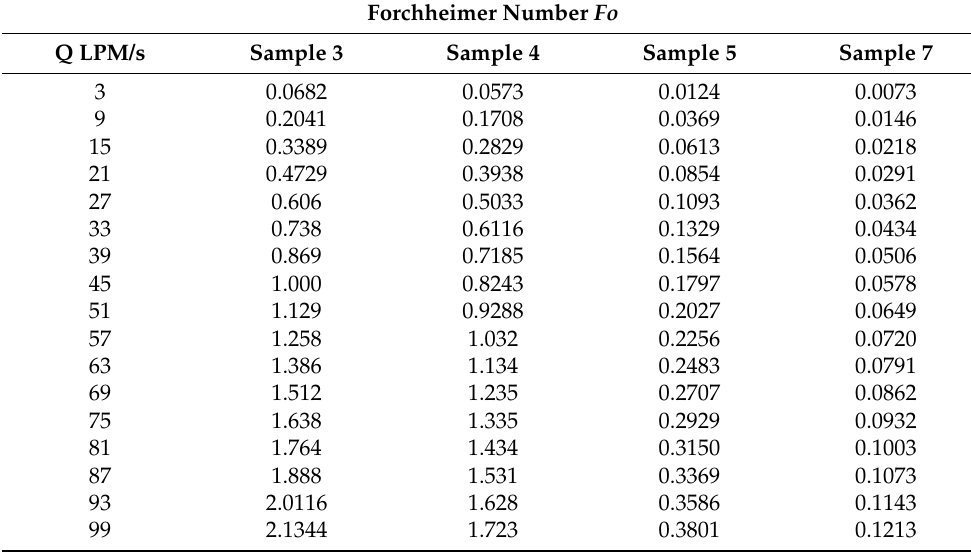
Table 4. Forchheimer number Fo